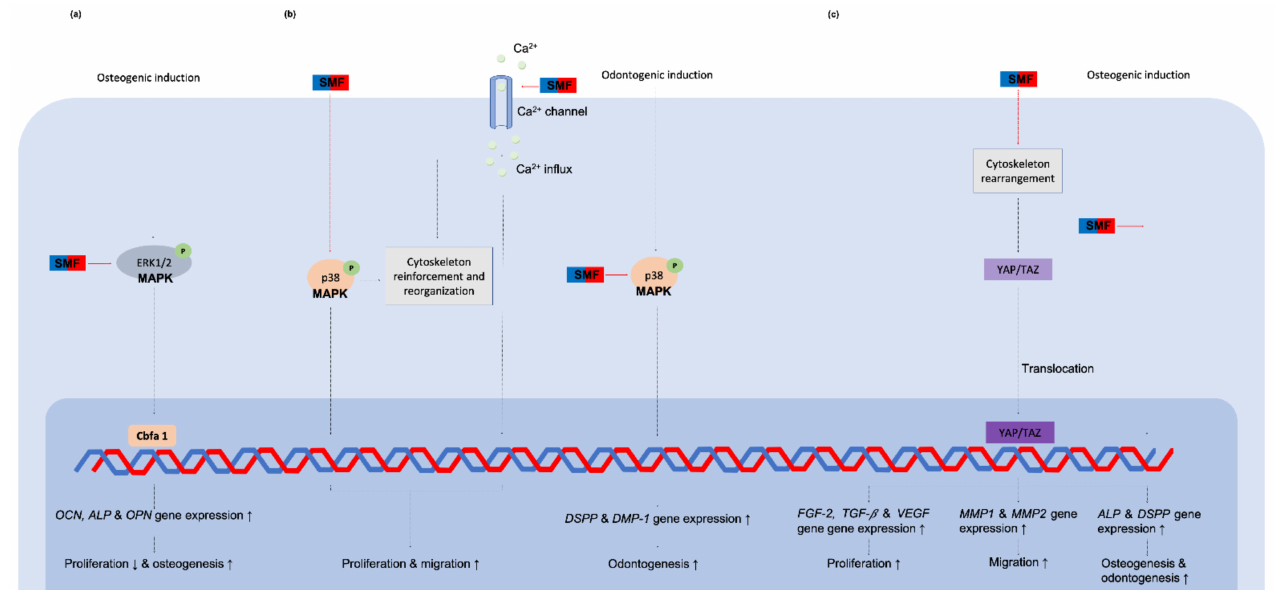
Figure 6. The relevant signaling cascades for dental pulp-derived cells when stimulated by SMFs. ( a ) ERK1/2-Cbfa 1 signaling was activated by SMF when cells were induced with osteogenic stimulation [25]; ( b ) Intracellular calcium ion influx and p38 MAPK signaling were activated by 0.4 T SMF, causing cytoskeleton reorganization and cell behavior changes [64,65]; ( c ) SMF affected cytoskeleton rearrangement which facilitated YAP/TAZ translocation and enhanced cell proliferation, migration, and differentiation [22]. Abbreviations: DSPP = Dentin sialophosphoprotein; DMP-1 = Dentin matrix acidic phosphoprotein 1; YAP/TAZ = Yes-associated protein 1 and Transcriptional coactivator with PDZ-binding motif; FGF-2 = Fibroblast growth factor 2; TGF- β = Transforming growth factor beta; VEGF = Vascular endothelial growth factor; MMP = Matrix metalloproteinase.